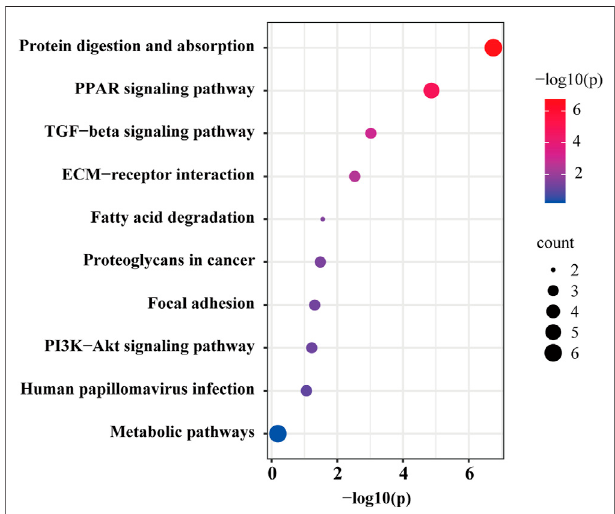
FIGURE 8 | The KEGG pathway analysis between the TGT group and control group.